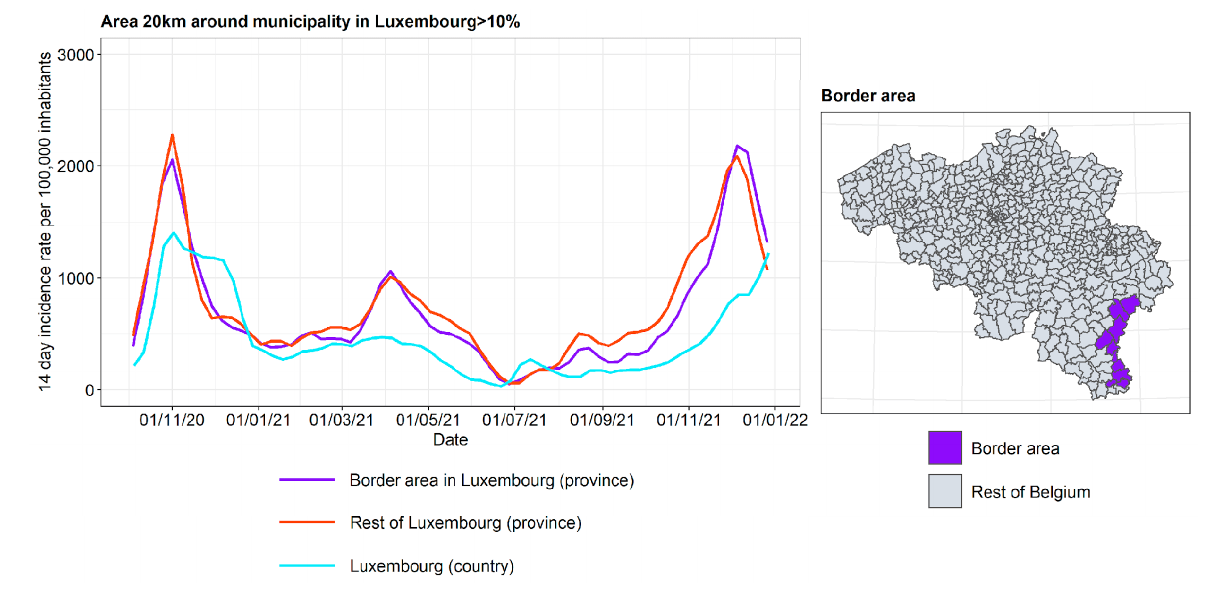
Figure 14. COVID-19 incidence curves for border area in BE-Luxembourg.